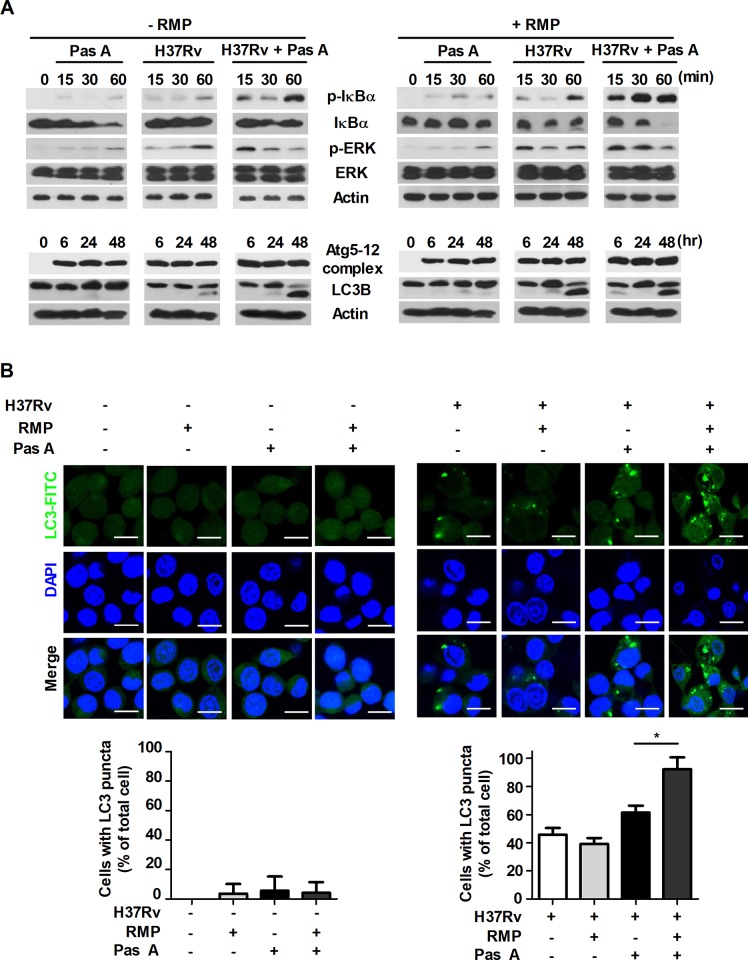
Treatment of pasakbumin A combined with RMP accelerates autophagy and the activation of NF-κB- and ERK1/2-mediated signaling compared to that of cells treated with pasakbumin A alone during Mtb infection.(A) Raw264.7 macrophages were infected with H37Rv (at a MOI of 5), and then treated with pasakbumin A (Pas A, 10 μM) in presence or absence of RMP for the indicated time points. (A) The expression levels of autophagy-related proteins as well as phosphorylated and total protein for various components of the NF-κB and MAPK signaling pathways were examined by western blot assay. Cropped membrane from different gels was used in western blot assay. (B) Raw264.7 macrophages were infected with H37Rv (at a MOI of 5) for 4 h, and then treated with pasakbumin A (Pas A, 10 μM) in presence or absence of RMP for 48 h. The LC3-positive macrophages after treatment with Pas A with or without RMP during Mtb infection were detected via immunofluorescence staining. The number of LC3-positive puncta was counted under a microscope, and the percentage of cells containing LC3-positive puncta relative to the total cell number was calculated. Bar scale, 20 μM. Statistical significance is indicated as *, p<0.05.